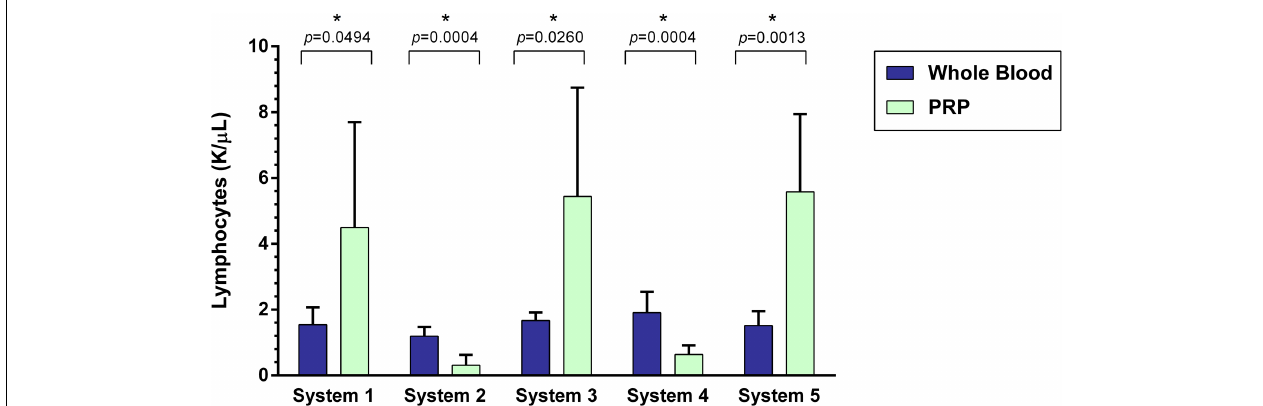
FIGURE 6 | Comparison of mean whole blood and mean PRP product lymphocyte concentrations between five commercial PRP systems . An asterisk (*) indicates a statistically significant difference between the mean whole blood and mean PRP product for that PRP system. Bars represent mean (cid:6) 95% CI ( n = 10).